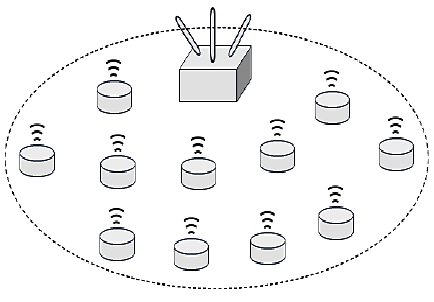
Figure 2. System